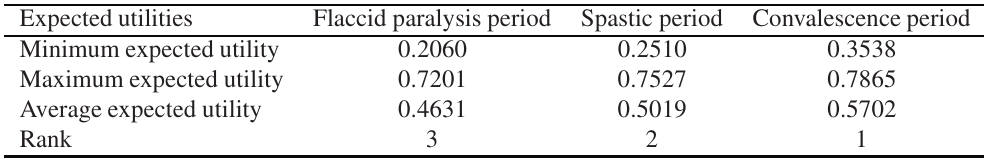
Table 6. The expected utilities of three periods and their ranking order using max-min